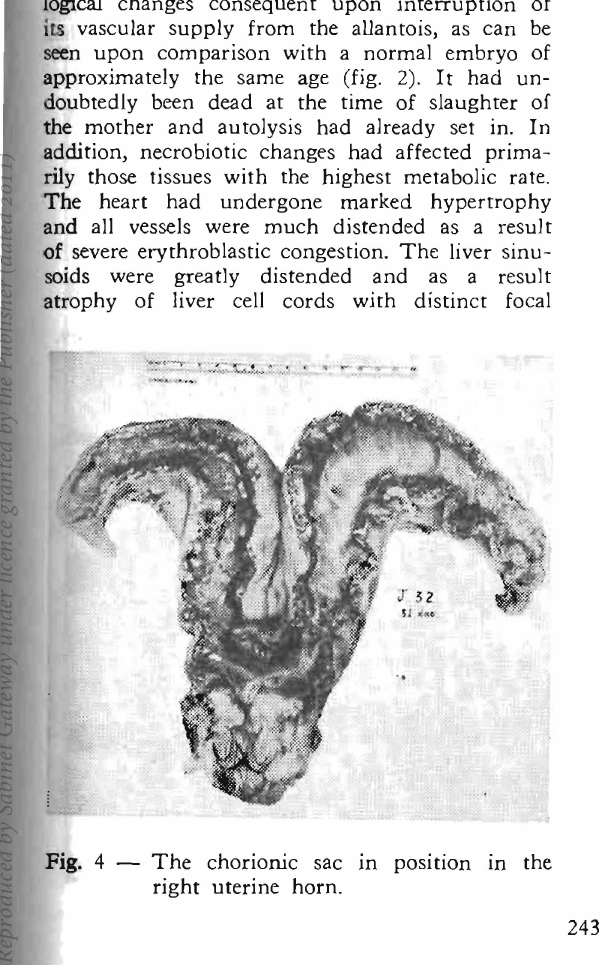
The chorionic sac In position In the right uterine